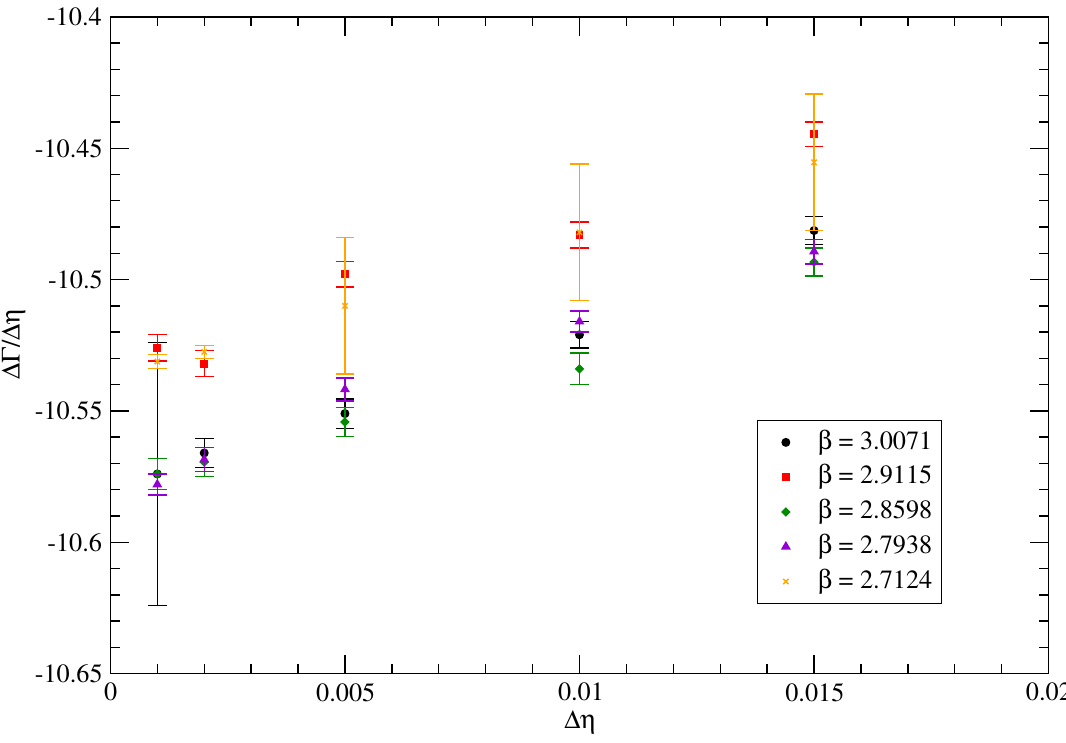
Figure 2 . The quotient ratio (cid:1)(cid:0) = (cid:1) (cid:17) , extracted from the simulation results listed in table 1, as a function of (cid:1) (cid:17) . The plot shows the results from \direct" non-equilibrium transformations at di(cid:11)erent (cid:12)